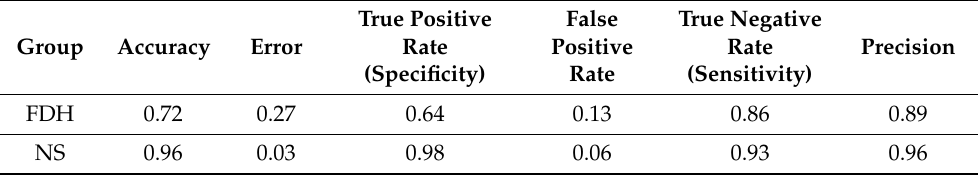
Table 3. Descriptive statistics obtained from the AX discrimination responses.